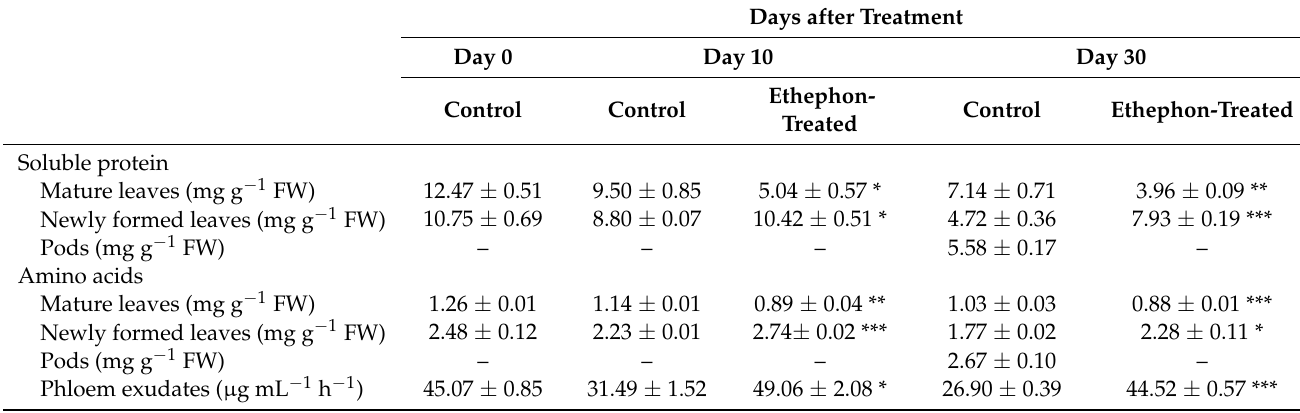
Table 2. Soluble protein and amino acid content in mature leaves, newly formed leaves, pods, and phloem exudates for the control and ethephon − treated plants before the ethephon application (day 0), at the end of ethephon application for 10 days (day 10), and an additional 20 days after the treatment (day 30). Data are presented as mean ± SE ( n = 3). Days after Treatment Day 0 Day 10 Day 30 Ethephon- Control